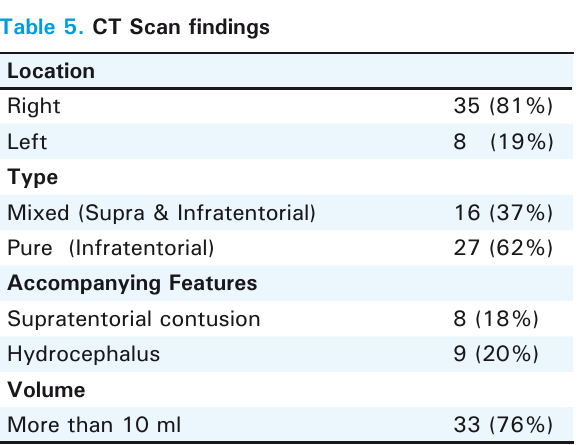
table 6. Glasgow Outcome Score (GOS) outcome at